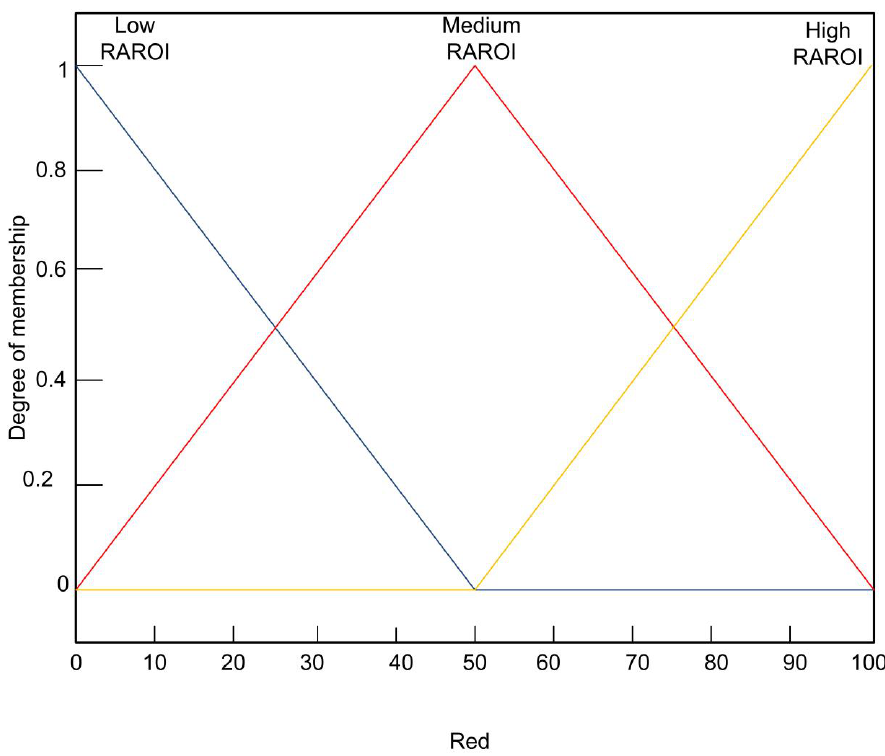
Figure 14. Membership functions of RAROI Figure 14